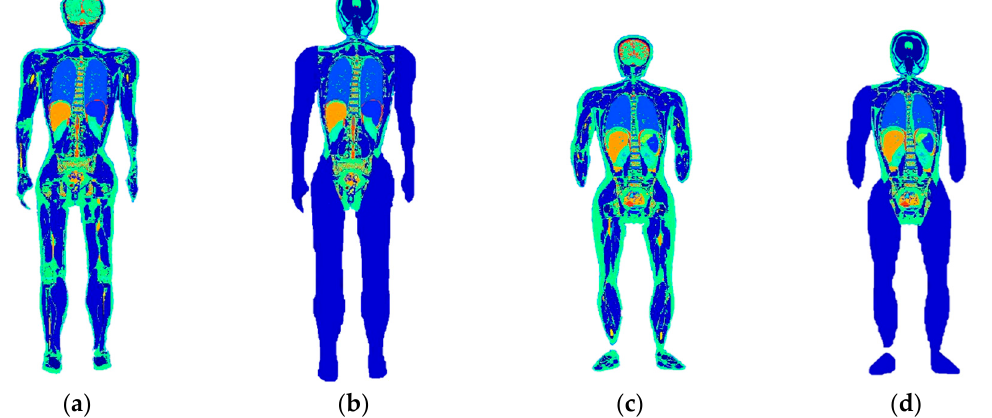
Figure 1. Human models used in the study: ( a ) Chinese adult male model by manual segmentation; ( b ) individualized adult male model; ( c ) Chinese adult female model by manual segmentation; ( d ) individualized adult female model.